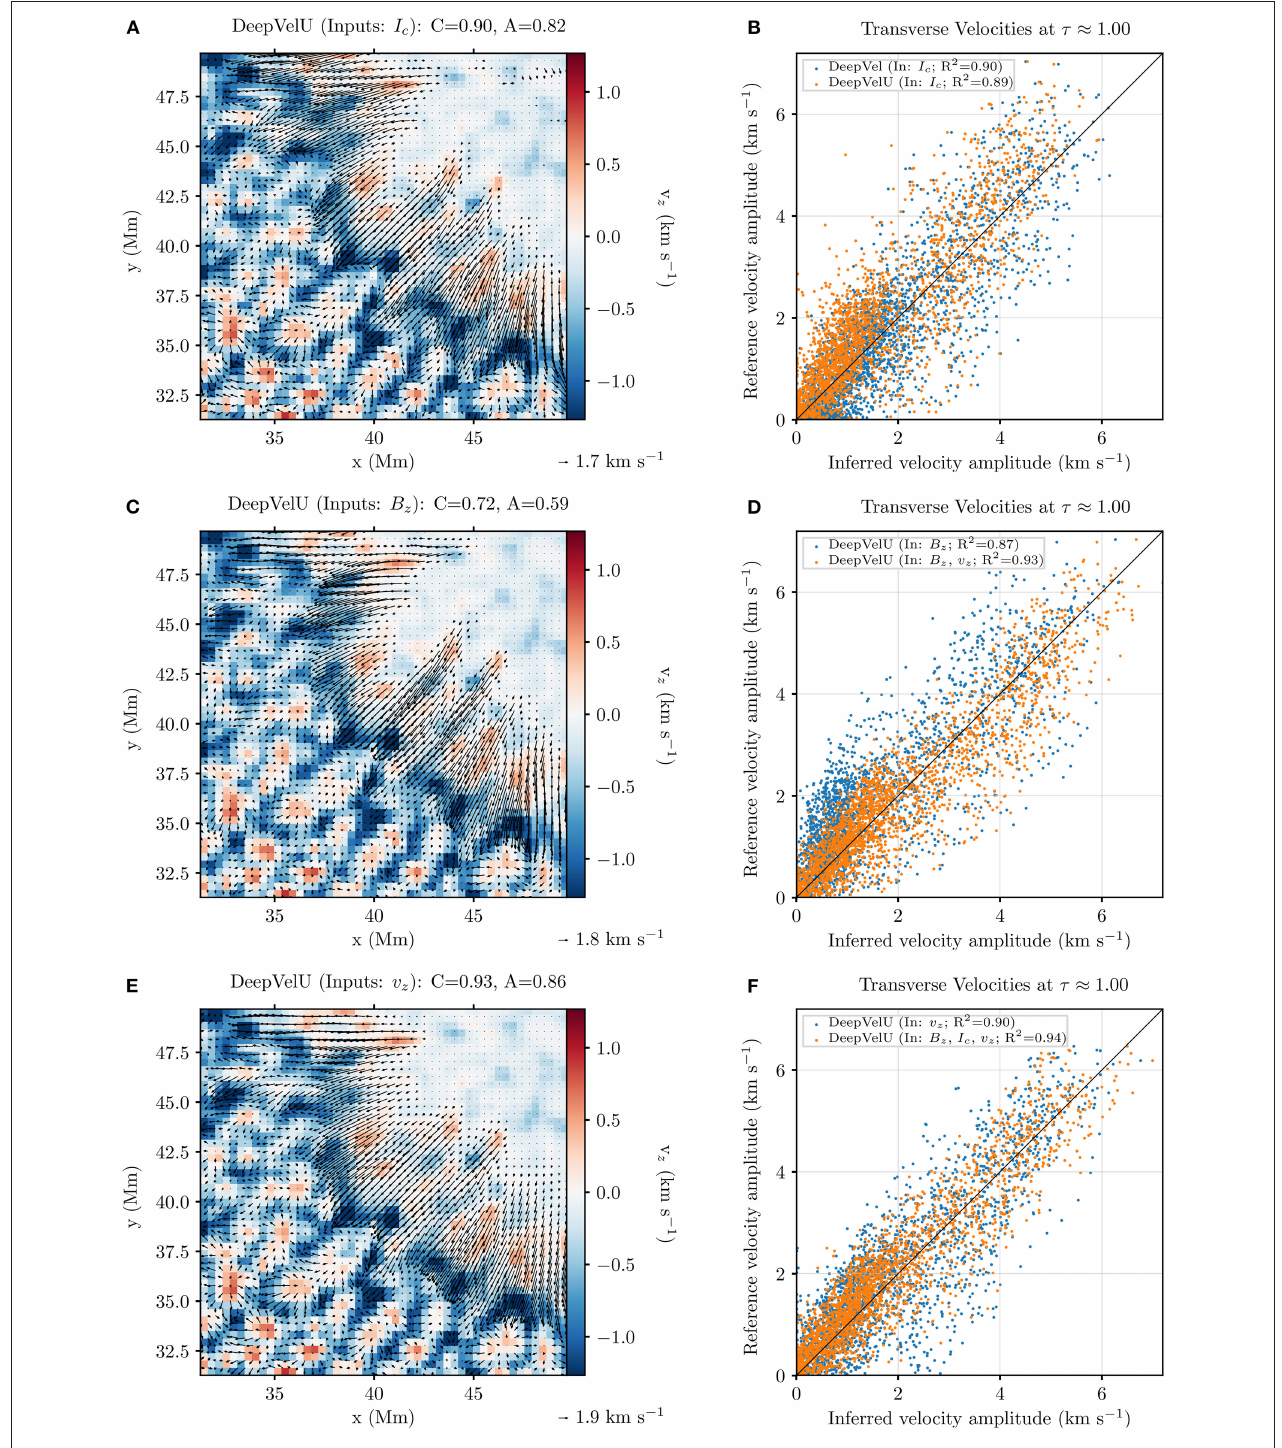
FIGURE 3 | (Left) Patches of 50 by 50 pixels 2 extracted from the 30-timestep-averaged E v D , t ( τ ≈ 1) inferred by DeepVelU from (A) I c ( t = t i , t i + 1 t ), (C) B z ( t = t i , t i + 1 t ), and (E) v z ( t = t i , t i + 1 t ). The 30-timestep-averaged v z ,ref computed by the MURaM simulation and resampled to the SDO/HMI resolution is displayed as background (colorscale). (Right) Scatterplots comparing |E v ref, t | to |E v D , t | inferred from a combination of intensitygrams I c ( t = t i , t i + 1 t ), magnetograms B z ( t = t i , t i + 1 t ) and Dopplergrams v z ( t = t i , t i + 1 t ). The black line represents the expected solution (i.e., R 2 = 1). (Right) Scatterplots comparing |E v ref, t | to |E v ref, t | inferred from a combination of (B) consecutive intensitygrams I c ( t = { t i , t i + 1 t } ), (D) magnetograms B z ( t = { t i , t i + 1 t } ) and Dopplergrams v z ( t = { t i , t i + 1 t } ), and (F) Dopplergrams, intensitygrams and